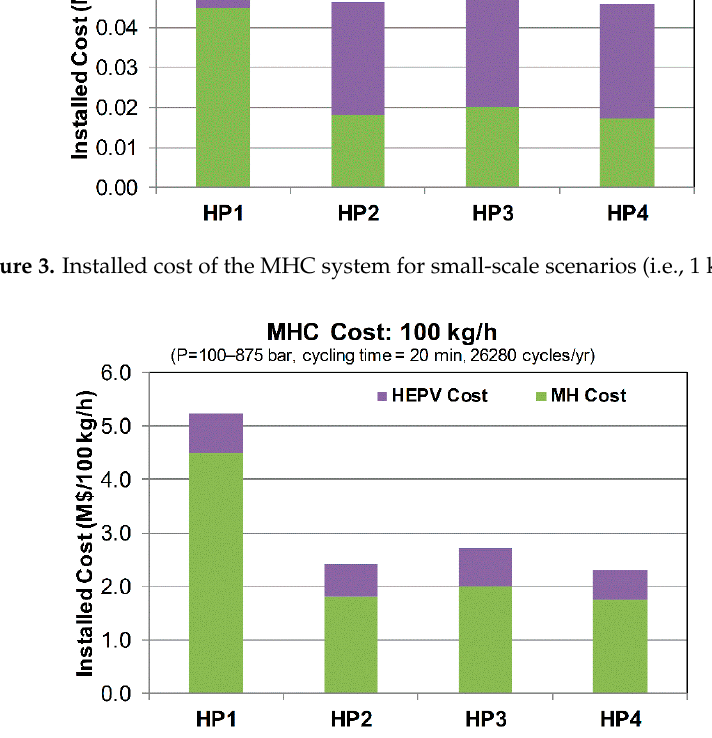
Figure 4. Installed cost of the MHC system for large scale scenarios (i.e., 100 kg H2 /h).